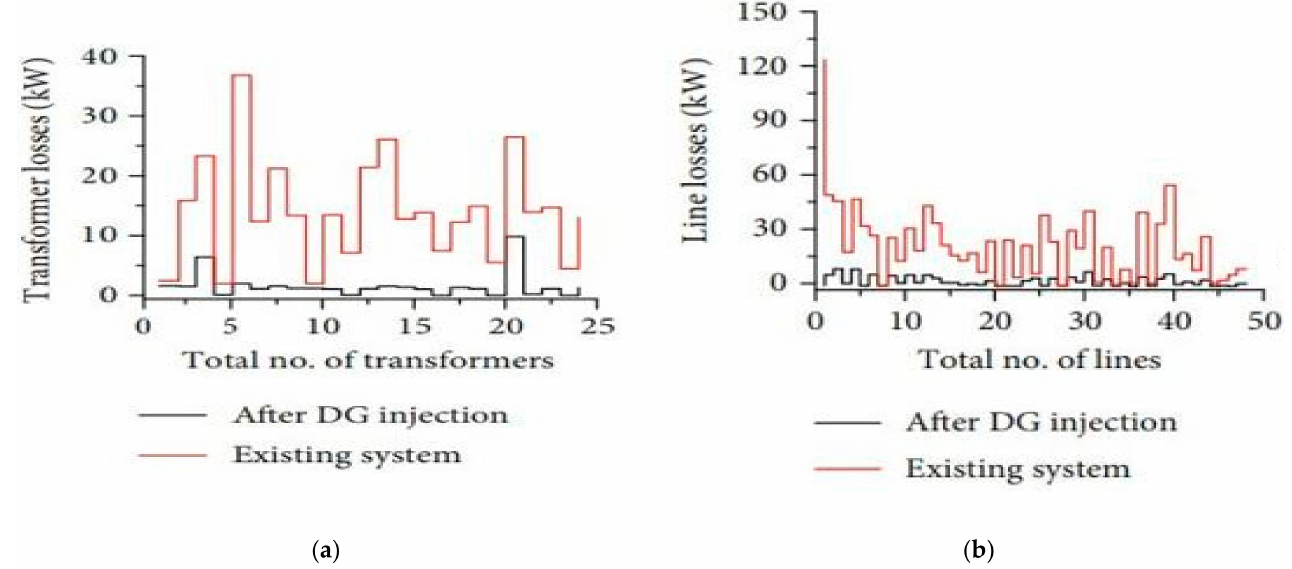
Figure 14. ( a ) Transformer losses and ( b ) line losses before and after DG injection [64].